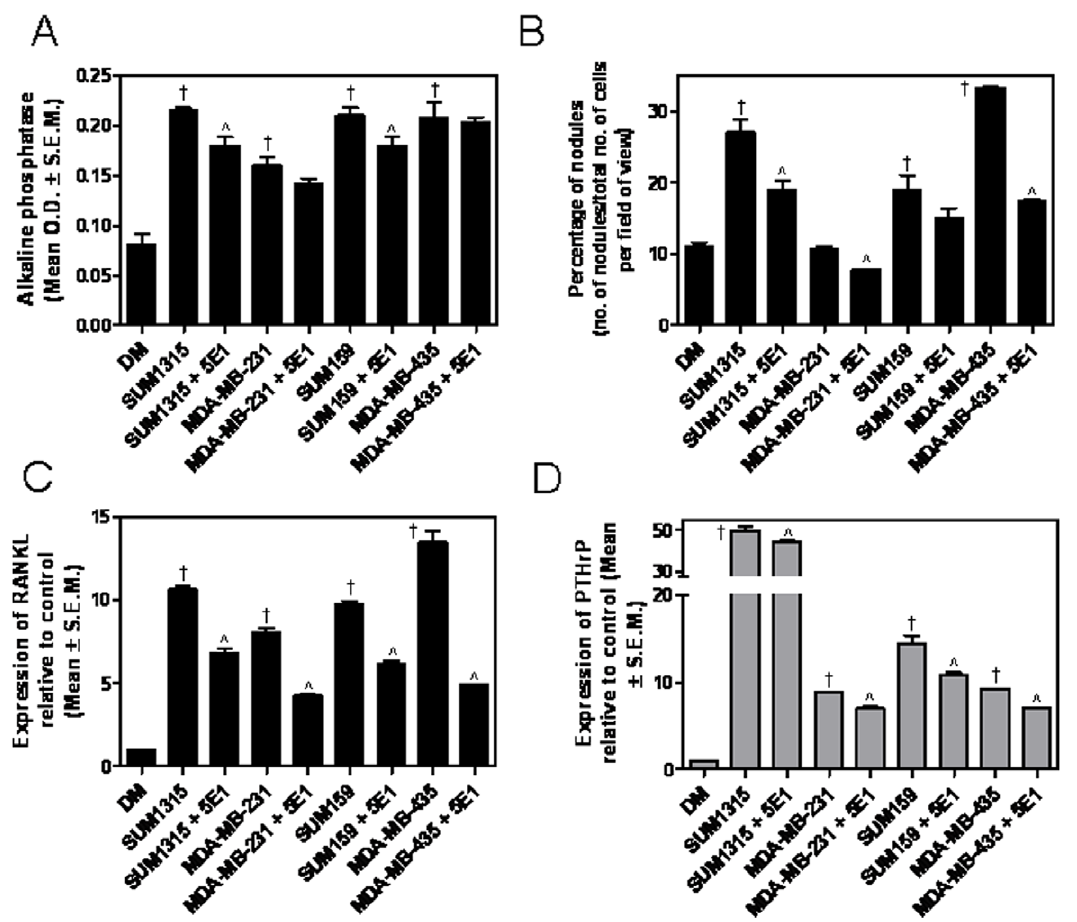
Figure 4. Hh ligands produced by tumor cells impacts the osteoblast differentiation and expression of RANKL and PTHrP. ( A ) Conditioned media from all four tumor cell lines caused a significant increase in ALP activity of MC3T3-derived osteoblasts: SUM1315 ( { p=0.0002); MDA-MB-231 ( { p=0.0035), SUM159 ( { p=0.0005), MDA-MB-435 ( { p=0.0009). Addition of the Hh neutralizing antibody, 5E1, caused a reduction in ALP activity. SUM1315 + 5E1 ( ‘ p=0.014); MDA-MB-231 + 5E1 (p=0.12), SUM159 + 5E1 ( ‘ p=0.04), MDA-MB-435 + 5E1 (p=0.6). ( B ) Tumor cell-conditioned media stimulated mineralization activity of the MC3T3-derived osteoblasts as evidenced by the numbers of mineralized nodules after Alizarin Red S staining. Nodules were counted in 12 independent fields and expressed as a percentage of the total number of cells in the field of view. SUM1315 ( { p=0.0013); MDA-MB-231 (p . 0.05), SUM159 ( { p=0.018), MDA-MB-435 ( { p , 0.0001). Addition of the Hh neutralizing antibody caused a reduction in numbers of mineralized nodules. SUM1315 + 5E1 ( ‘ p=0.02); MDA-MB-231 + 5E1 (p=0.0005), SUM159 + 5E1 (p=0.17), MDA-MB-435 + 5E1 (p , 0.0001). ( C ) The expression of RANKL by the differentiated MC3T3-derived osteoblasts was significantly increased in presence of tumor cell-conditioned medium. ( { p=0.0013, for all four tumor cell lines). Neutralization of the Hh ligand with the 5E1 antibody caused a reduction in the levels of RANKL expressed. SUM1315 + 5E1 ( ‘ p=0.0004); MDA-MB-231 + 5E1 ( ‘ p=0.0002), SUM159 + 5E1 ( ‘ p=0.0003), MDA-MB-435 + 5E1 ( ‘ p=0.0002). ( D ) The expression of PTHrP by the MC3T3-derived osteoblasts was notably greater in presence of conditioned medium from the tumor cells (p , 0.0001 for all tumor cells). Neutralization of Hh ligand caused a significant decrease in the levels of PTHrP. SUM1315 + 5E1 ( ‘ p=0.04); MDA-MB-231 + 5E1 ( ‘ p=0.0001), SUM159 + 5E1 ( ‘ p=0.01), MDA-MB-435 + 5E1 ( ‘ p , 0.0001). The expression of RANKL and PTHrP were assessed by real time qRT-PCR after 14 days